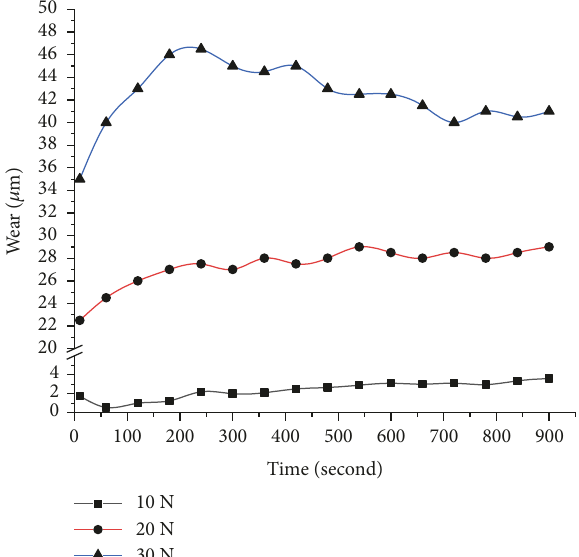
Figure 12: Variation of coefficientof friction atvarious loads and for 20% Al 2 O 3